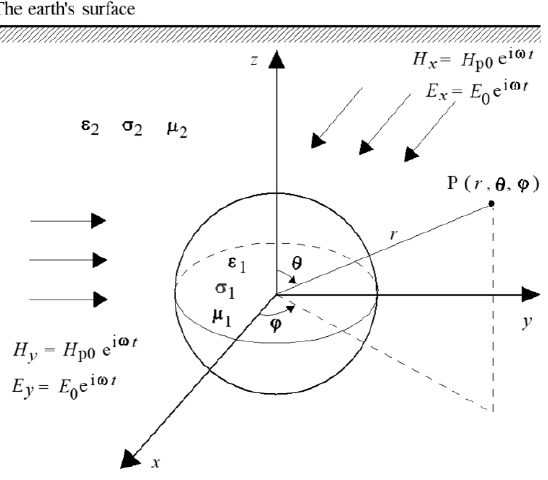
Figure 5. A sphere in natural alternating electromagnetic field in half space.